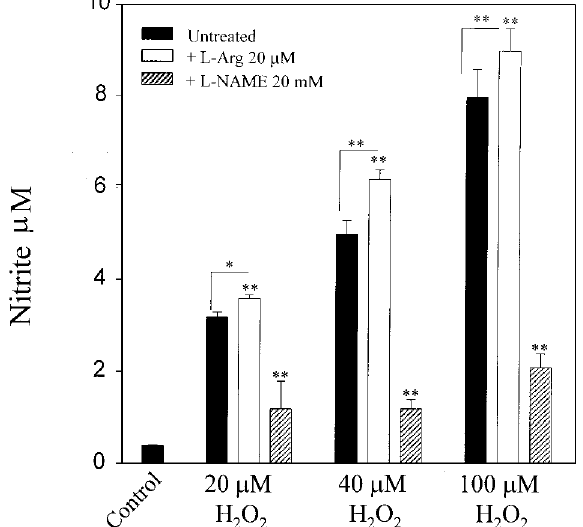
FIG. 3. Production of NO by HUVECs, measured after 24h incubation, after addition of three concentration of H 2 O 2 . Effects of the addition of L-arginine and L-NAME. The data are presented as the arithmetic mean ±SD of 6 different